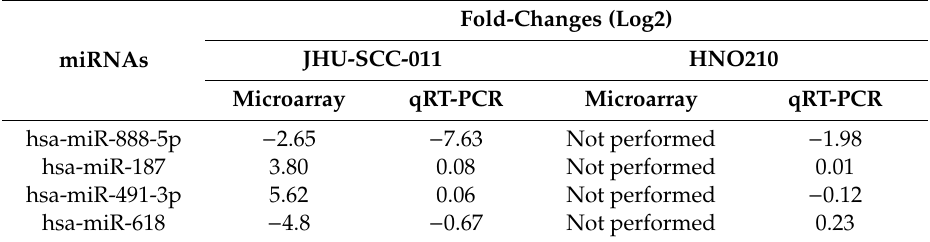
Table 1. Comparison of fold changes detected in microarrays and by qRT-PCR. Fold-Changes (Log2) JHU-SCC-011 HNO210 miRNAs